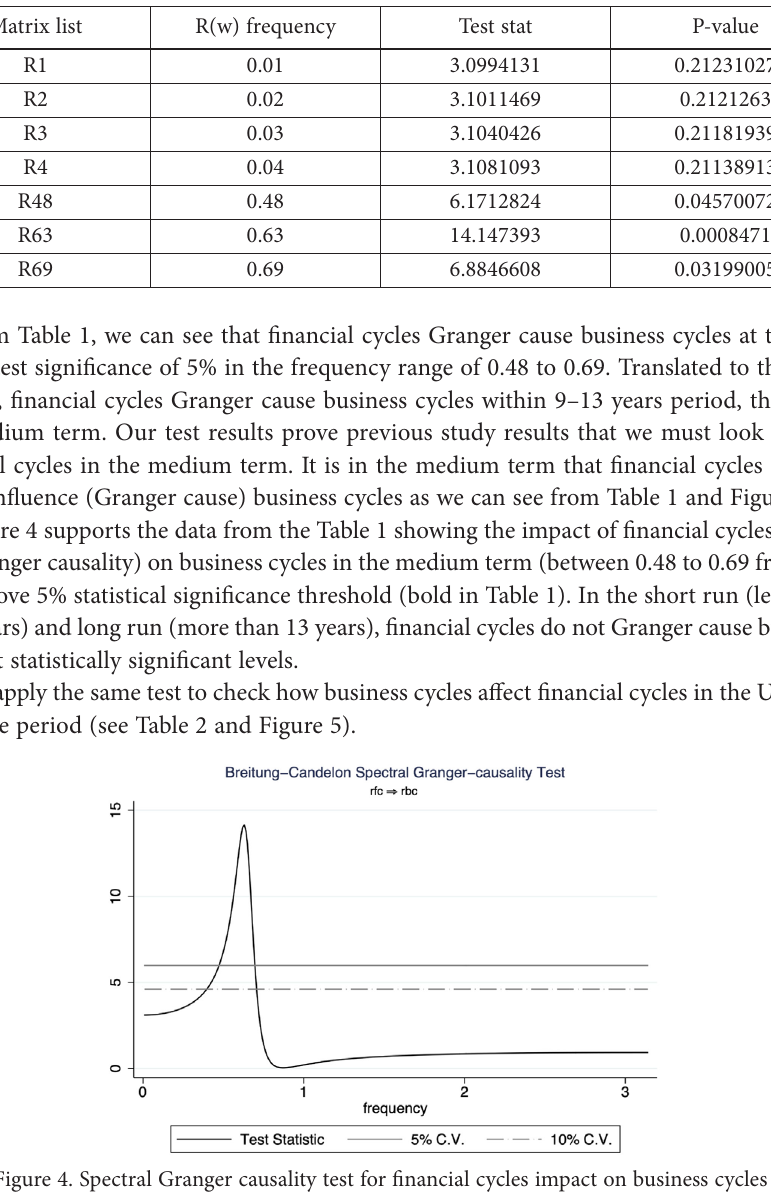
Table 1. Spectral Granger causality test results (financial cycles impact business cycles) (source: authors’ calculation)